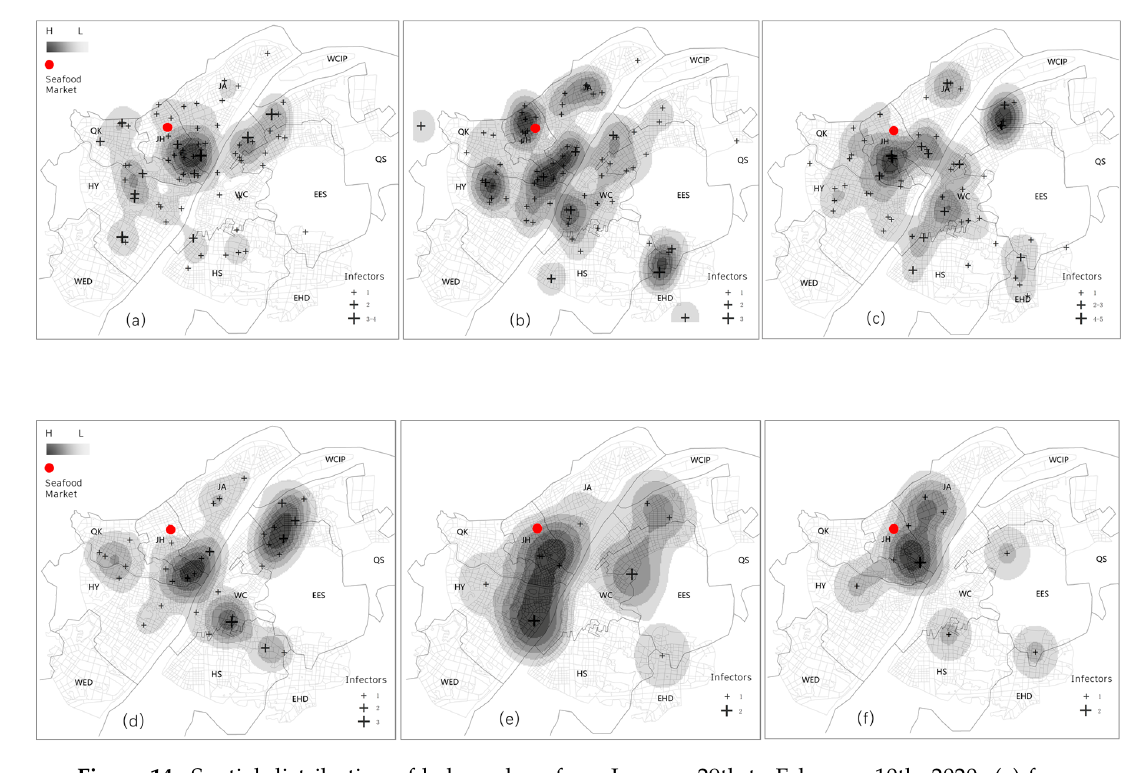
Figure 14. Spatial distribution of help seekers from January 29th to February 10th, 2020: ( a ) from